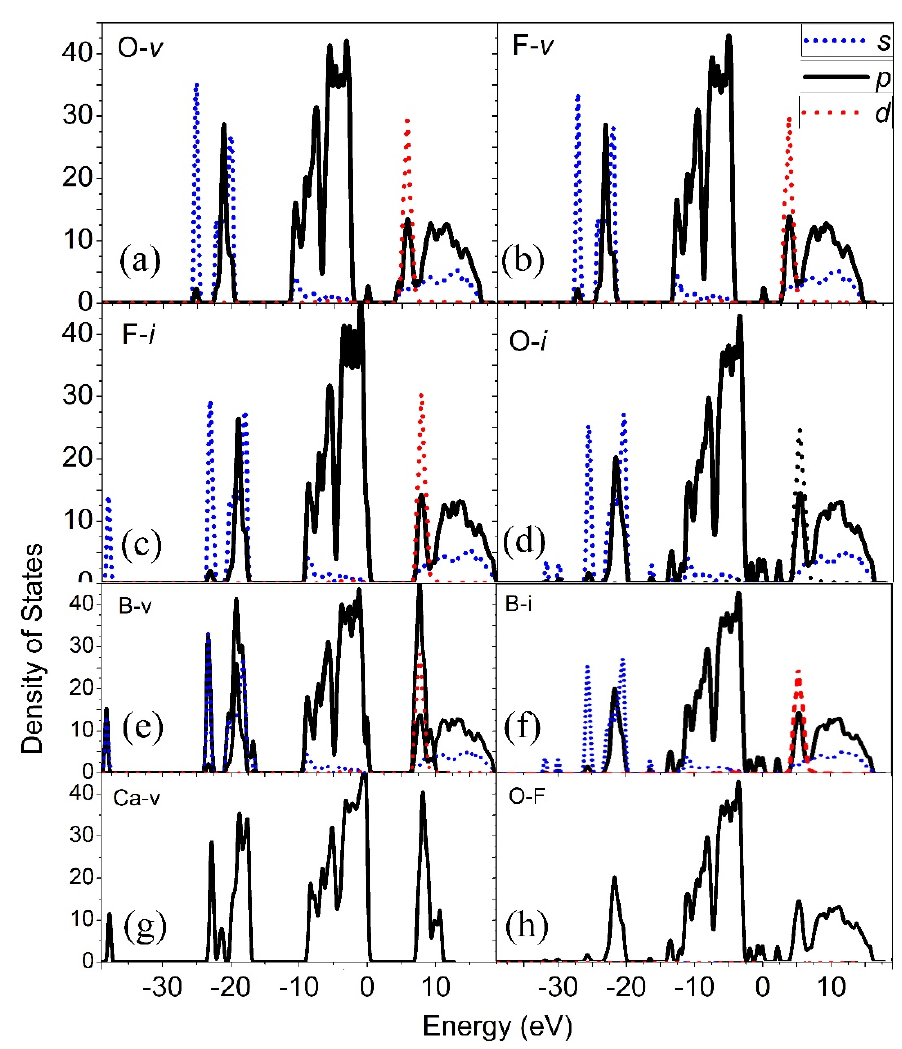
Figure 5. The representative of the DOS and LDOS of 15 point defects in CBOF, such as( a ) V O , ( b ) V F , ( c ) F i , ( d ) O i , ( e ) V B , ( f ) B i , ( g ) V Ca , and ( h ) O F , respectively.